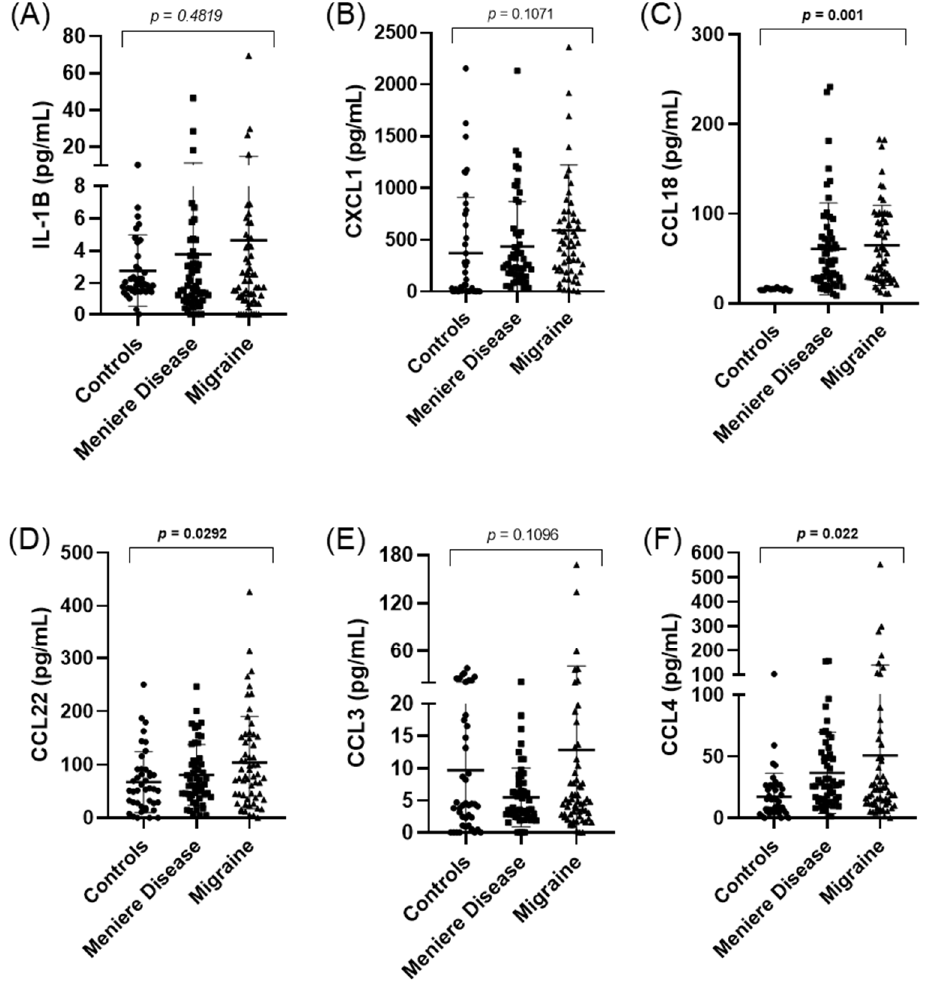
Figure 5. Scatter plots showing cytokines with the concentrations of IL-1 β ( A ), CXCL1 ( B ), CCL18 ( C ), CCL22 ( D ), CCL3 ( E ), and CCL4 ( F ) in healthy controls, patients with MD, and migraine. Significant differences ( p < 0.05) are highlighted in